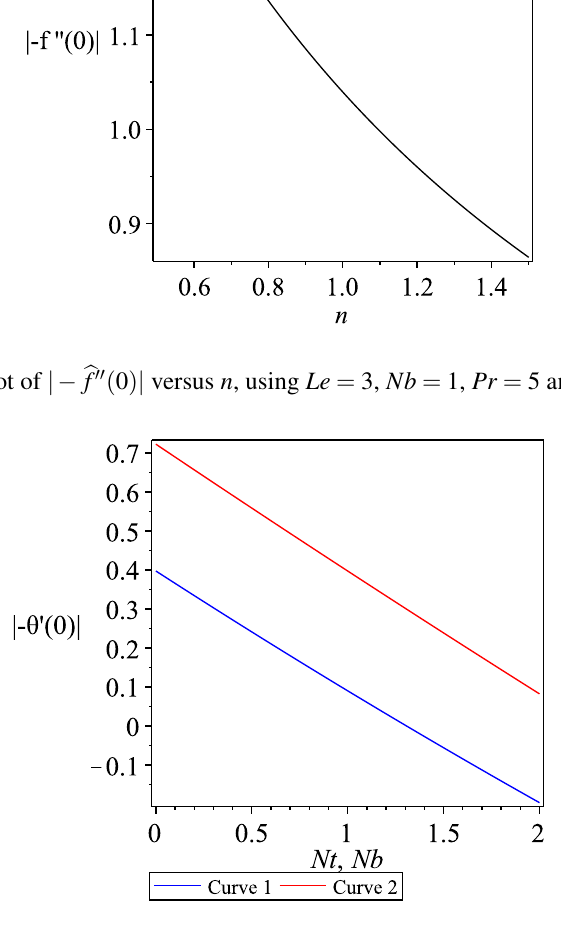
Fig. 12 Plot of |− (cid:98) θ (cid:48) ( 0 ) | , where Curve 1 is |− (cid:98) θ (cid:48) ( 0 ) | versus Nt using Le = 3, Nb = 1, Pr = 5, n = 1, Curve 2 is |− (cid:98) θ (cid:48) ( 0 ) | versus Nb using Le = 3, Pr = 5, Nt = 0, n =